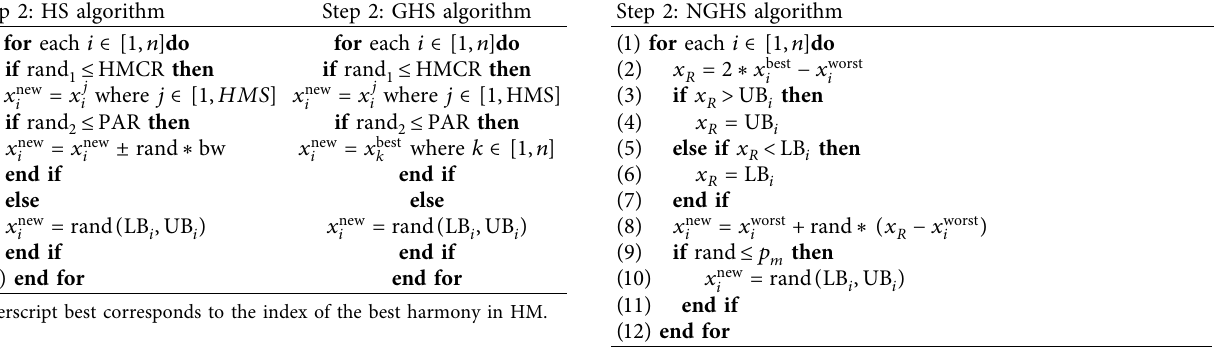
Table 2: Improvisation step of the NGHS algorithm. Step 2: NGHS